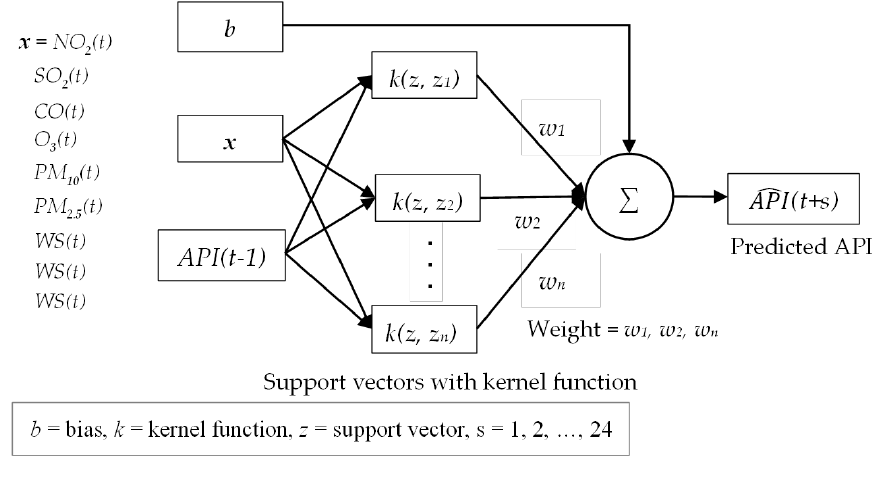
Figure 4. The SVR model for s-multi-step predictions.